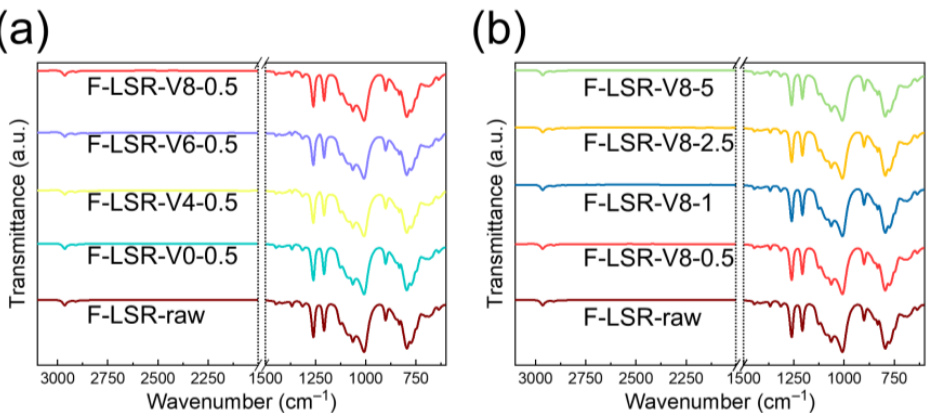
Figure 1. FT-IR spectra of the prepared F-LSR-POSSs with ( a ) various types of POSS-Vs and ( b ) different amounts of POSS-V8.